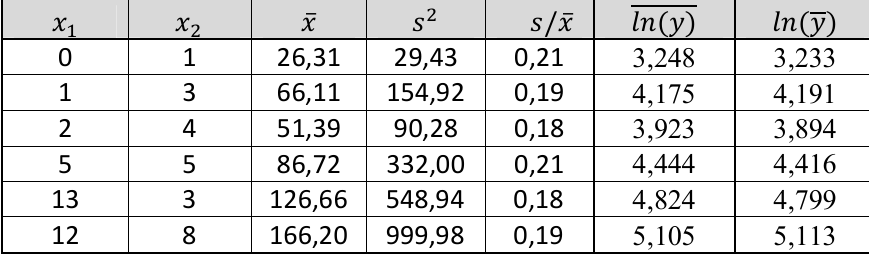
Table 2 - Statistical characteristics calculated from the data in table